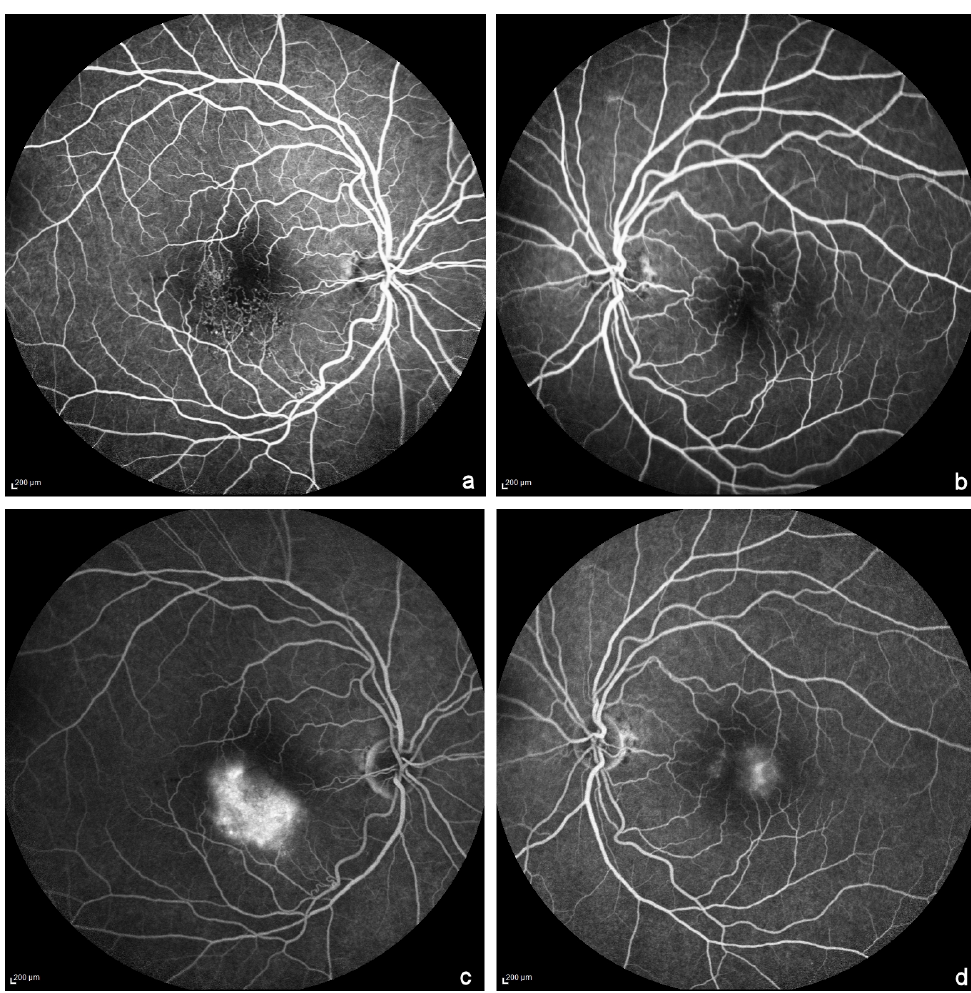
Figure 3: Fundus Fluorescein angiography early (a,b) and late phase (c,d). In the right eye, telangiectatic vessels in the temporal and inferior parafovea with few microaneurysms are seen in the early phase (a). In the left eye, microaneurysms in the parafoveal region are seen in the early phase (b). Late phase images show diffuse hyperfluorescence in the right eye (c) and mild staining of the temporal parafovea in the left eye (d).